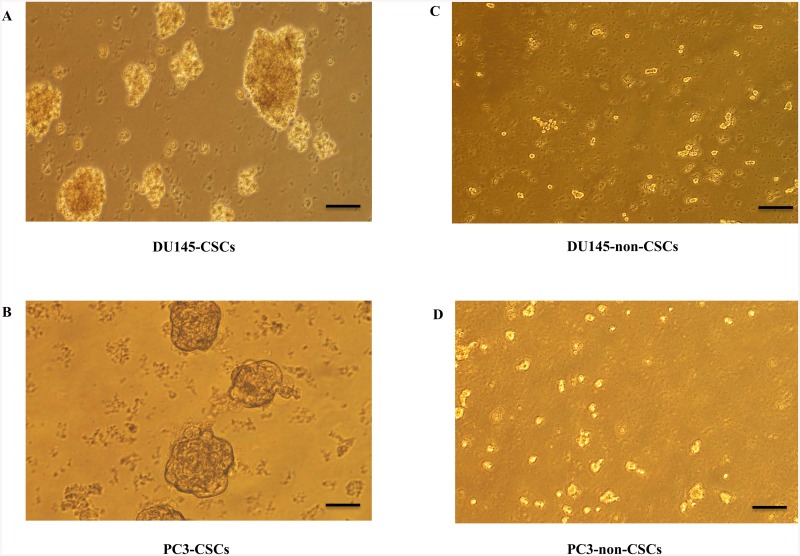
The spheroid formation potential of CSCs and non-CSCs.A) DU-145 CSCs, B) PC-3 CSCs, (C) DU-145 non-CSCs, (D) PC-3 non-CSCs. CD133high/CD44high human prostate CSCs were able to form spheroids; whereas non-CSCs failed.